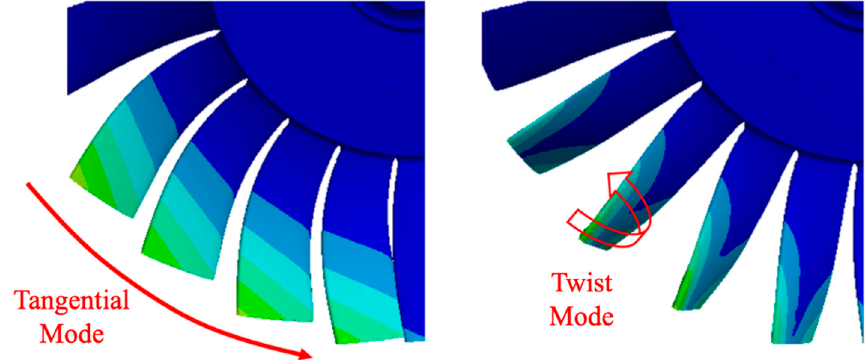
Figure 6. A typical mode shape of TRT rotor.